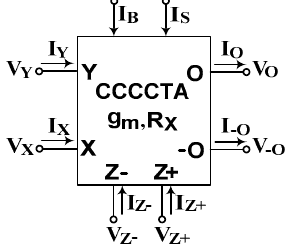
Figure 1. CCCCTA (current controlled current conveyor transconductance amplifier) symbolic representation.